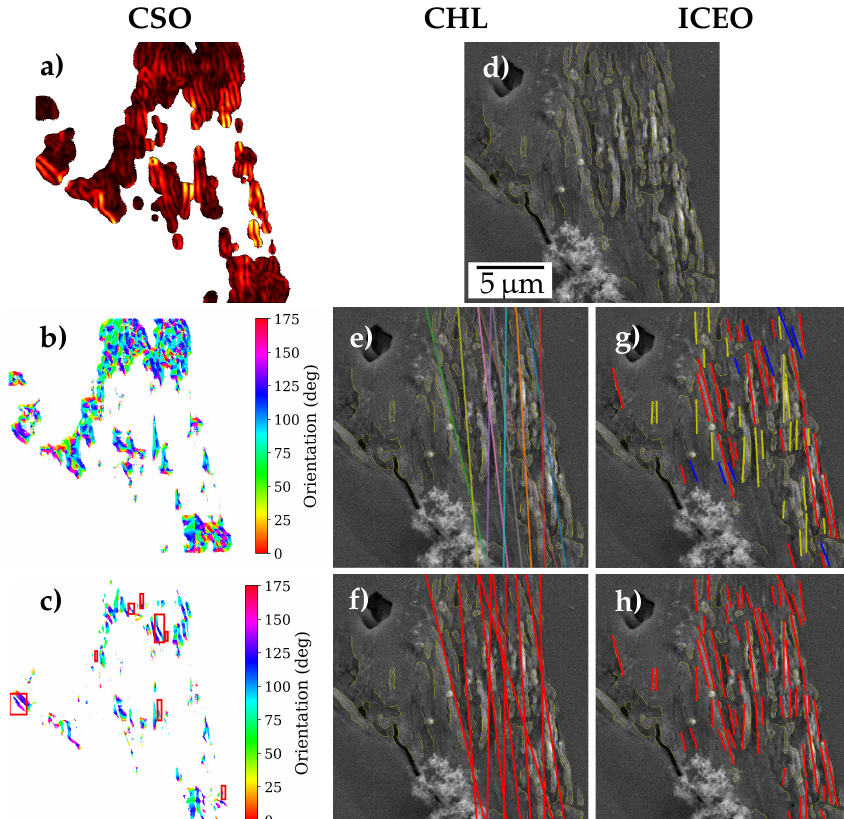
Figure 5. Overview of the methods to detect slip trace orientations (STOs) (illustrated based on Figure 4b): For the clustering of Scharr gradient based edge orientations (CSO), gradient ( a ) magnitude and ( b ) orientation of high confidence region, and ( c ) the selected orientation blobs after thresholding and filtering are depicted. Image ( d ) shows filtered skeletons after Canny and morphological operations, which are common for clustering Hough lines from edges (CHL) and iterative clustering of edge orientations (ICEO). ( e ) The Hough lines detected and ( f ) clustered in CHL are shown. ( g ) Clusters after orientation-based clustering in ICEO and ( h ) after centroid-based iterative merging of clusters are illustrated. All figures have the same